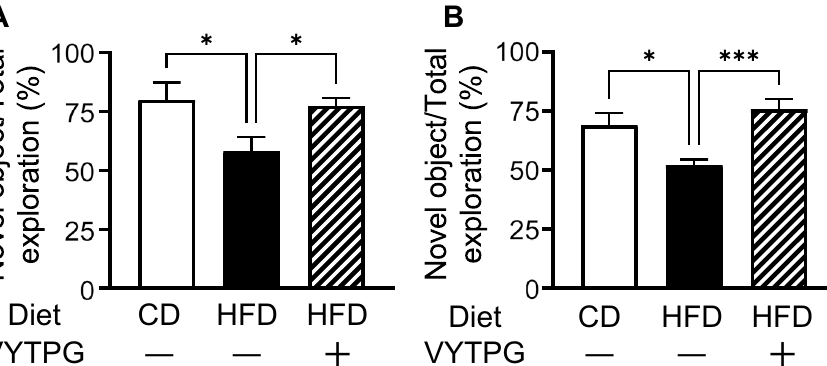
Figure 2. VYTPG improved cognitive decline in mice treated with HFD after oral administration. Mice were fed CD or HFD for a week and orally administered saline or VYTPG at a dose of 1 mg/kg (once a day for 3 days). ( A ) Thereafter, the novel object recognition test (ORT) was performed. ( B ) The object location test (OLT) was also performed similarly to the novel ORT. All values are means ± SEM ( A , n = 4–6; B , n = 5–7). * P < 0.05, *** P < 0.001 vs. HFD